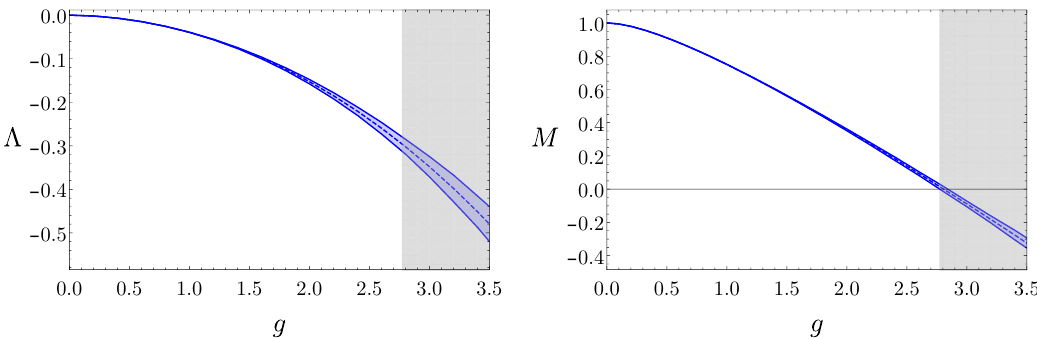
Figure 1 . The vacuum energy (cid:3) (left) and the mass gap M (right) as a function of the coupling constant g obtained by Borel resumming the perturbative series using the coe(cid:14)cients up to the g 8 order. The values reported of (cid:3) and M for g > g c (cid:25) 2 : 8, where a phase transition occurs, refer to the extrapolation using the Borel resummed function.